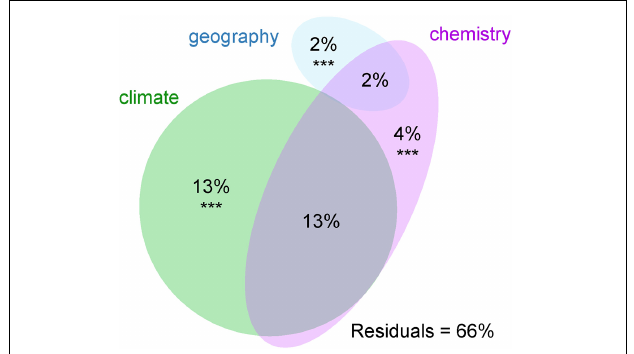
FIGURE 4 | Variation partitioning of the effects of environmental variables on the photobiont-mycobiont modules found by modularity analysis. Variables significantly contributing to the variation explained ( p < 0.001) are marked with